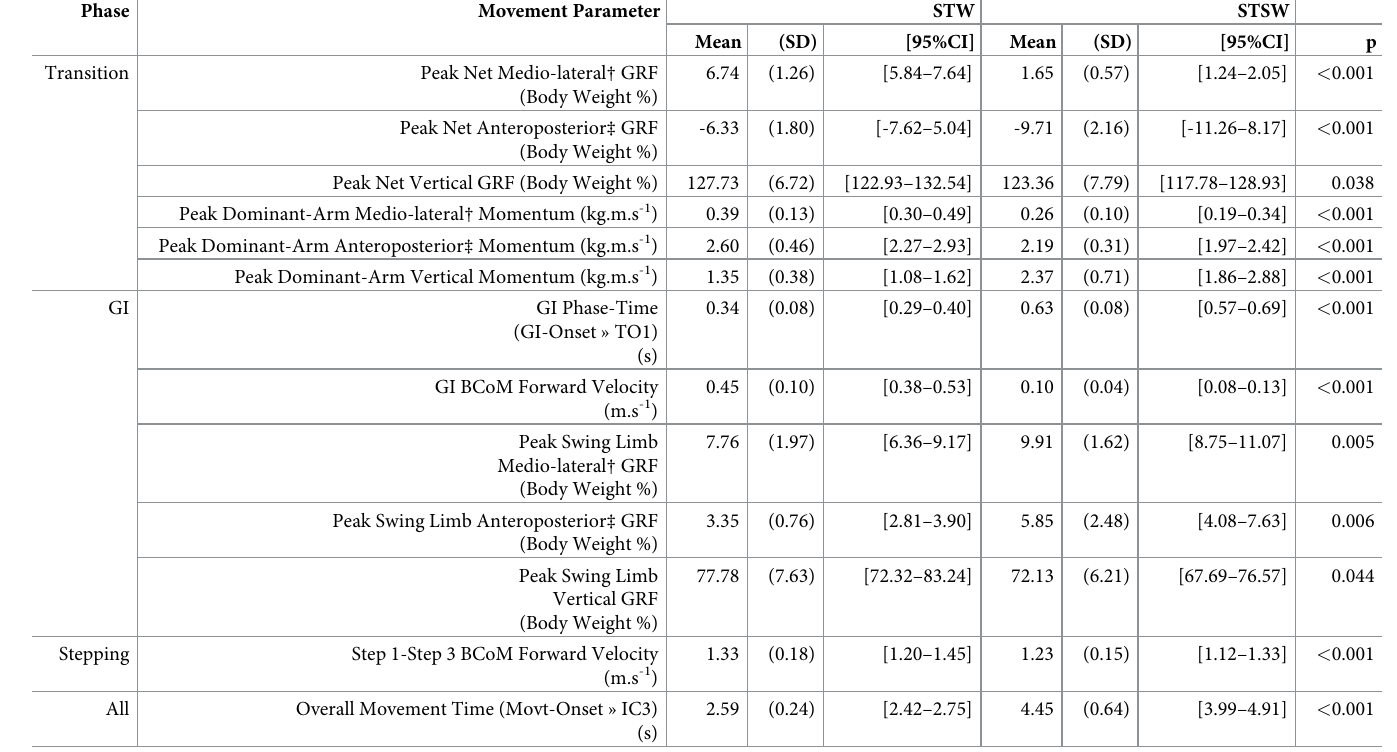
Table 3. Mean (SD) [95%CI] for movement parameters with significant difference between STW and STSW. Phase Movement